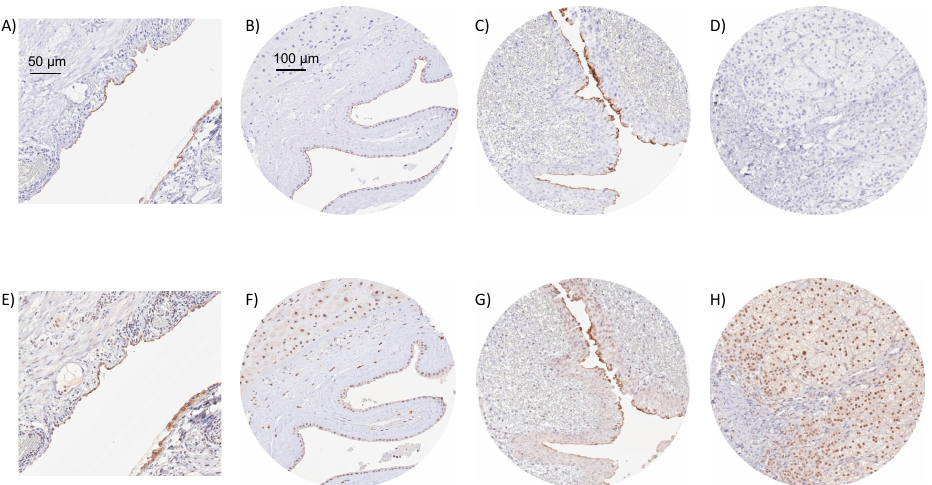
Figure 2. IHC validation by comparison of antibodies. Using MSVA-736M, an apical membranous Upk3b positivity is seen in mesothelial cells covering an appendix ( A ), amnion cells of a placenta ( B ), and umbrella cells of the renal pelvis urothelium ( C ), while staining is absent in adrenal gland ( D ). Using clone C362, a similar membranous staining is seen in mesothelial cells of the appendix ( E ), amnion cells ( F ), and urothelial umbrella cells ( G ), despite of a higher level of background staining. Clone C362 also results in a significant nuclear staining of adrenocortical cells ( H ) which is not seen by MSVA-736M.